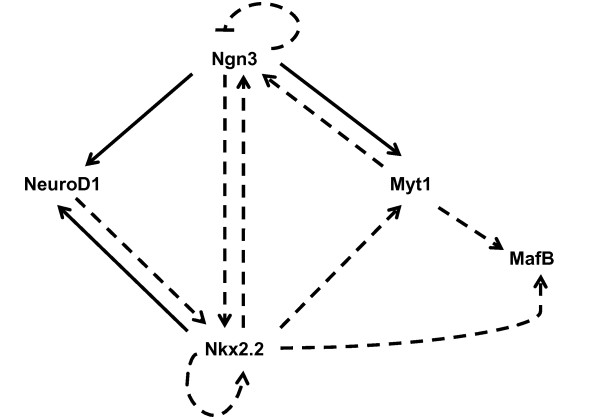
A proposed model for an Nkx2.2 role during endocrine cell specification at the secondary transition. The solid arrows indicate direct activation that is based on published regulatory data, while dashed arrows represent untested direct regulatory interactions proposed here as well as by other groups and in some cases known indirect regulation.